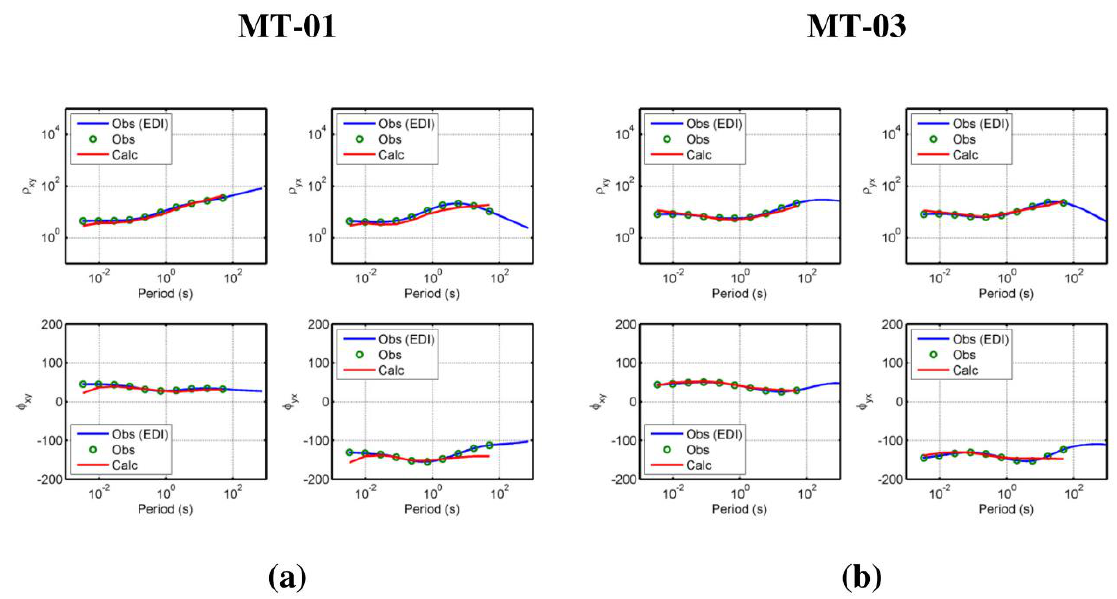
Figure 6. Apparent resistivity and phase fitting between observed and calculated data generated from the 3D inversion for MT data from MT-01 ( a ) and MT-03 ( b ). The blue solid line depicts observed field data, the green circles depict resampled data at the ten frequencies chosen, and the red solid line depicts calculated data.